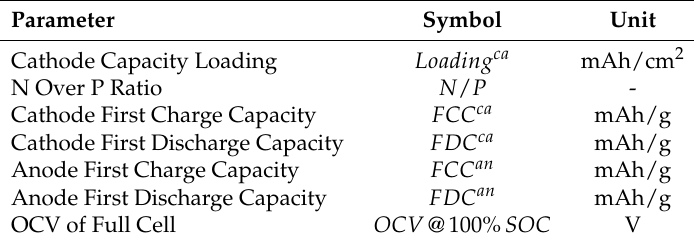
Table 1. Influential factors for identifying cell balance and OCV